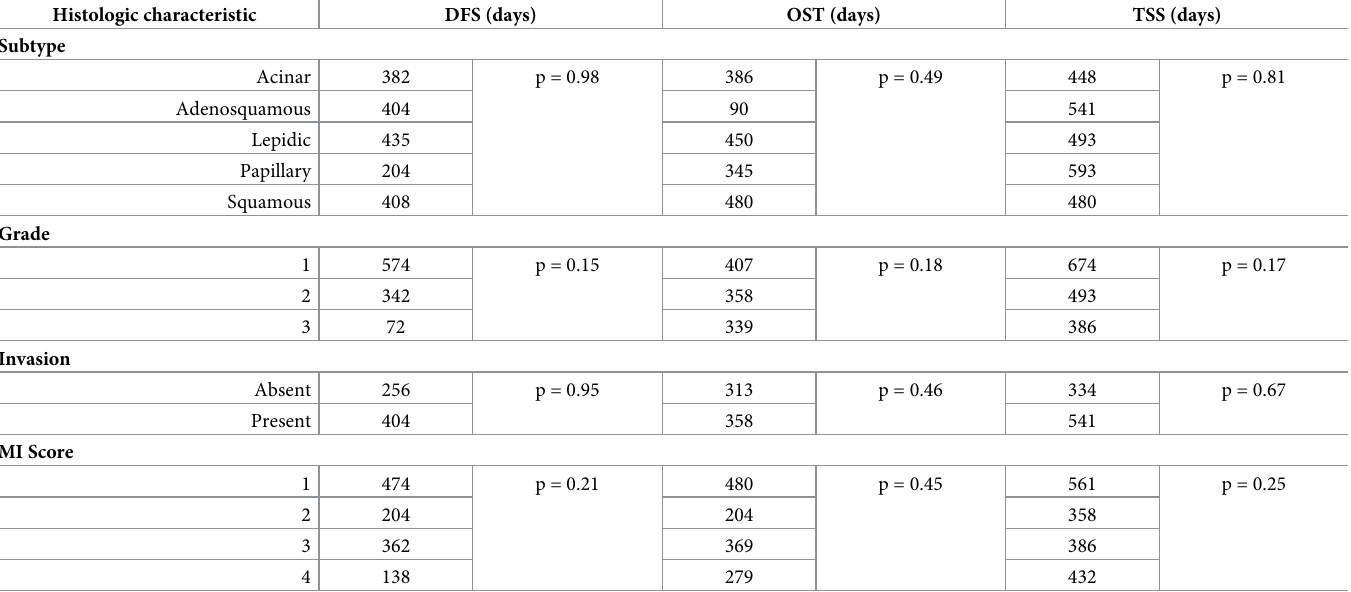
Table 6. Outcome for dogs with lung adenocarcinoma following surgical resection. Histologic characteristic